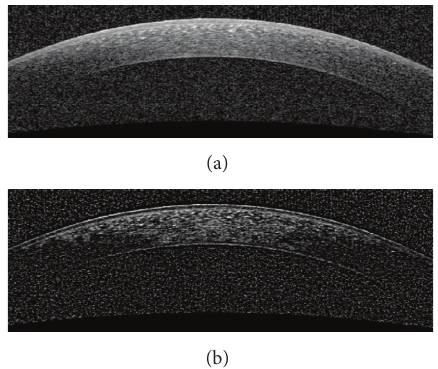
Figure4:Contrastenhancementoforiginalimageforsegmentation of Bowman boundary. (a) Original image. (b) The enhanced image.